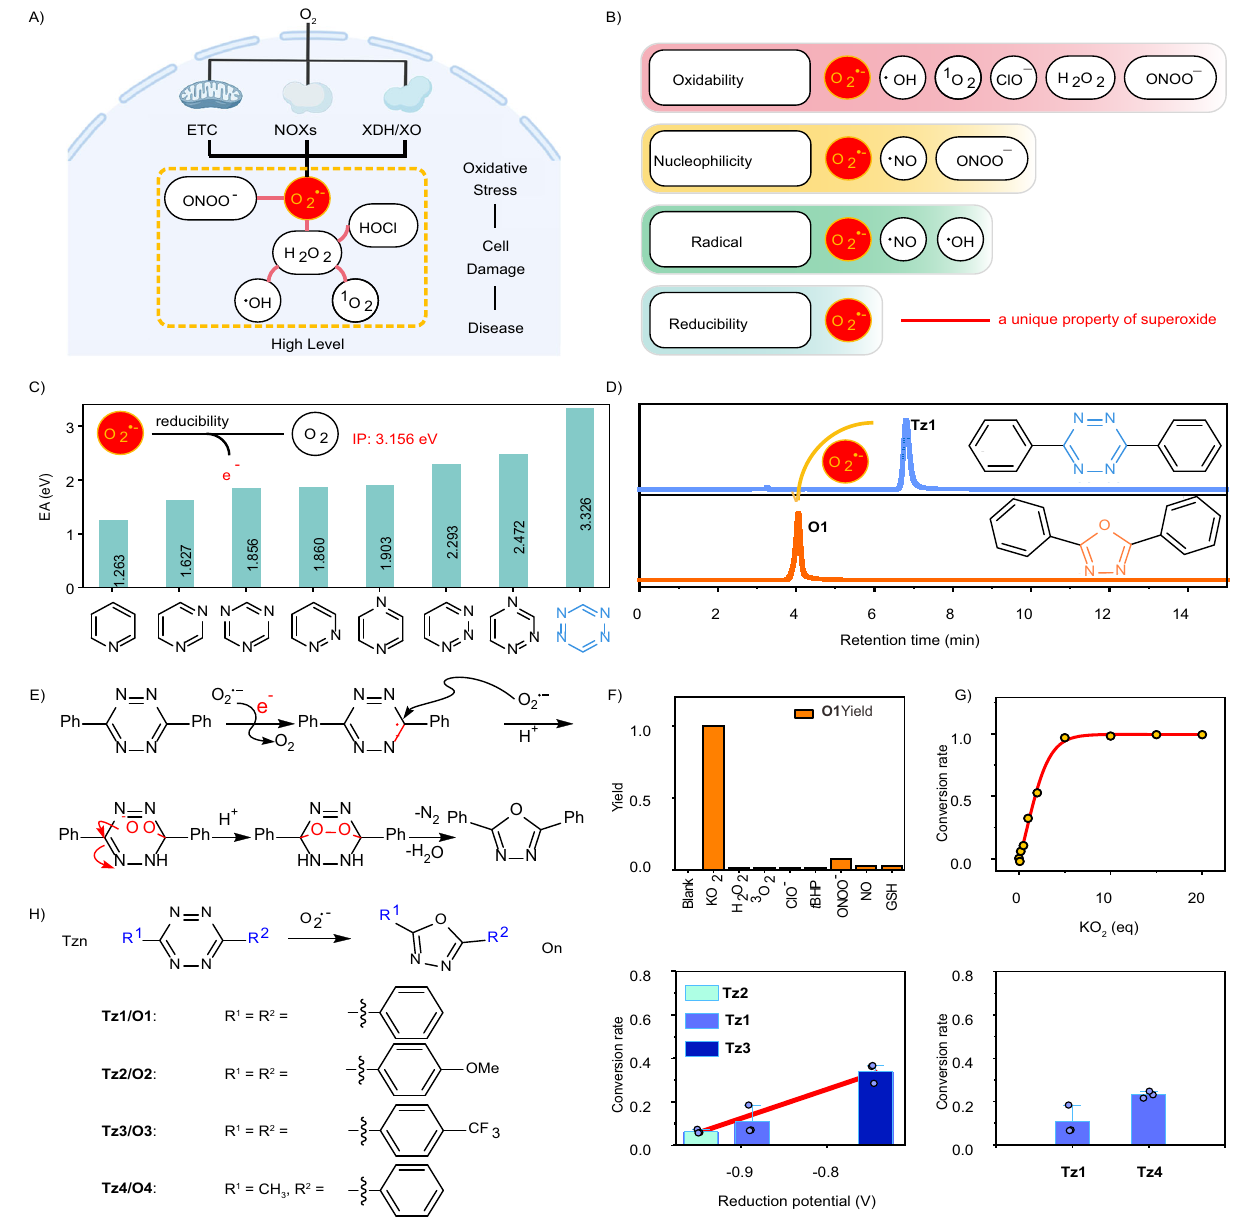
Fig.1|Designoftetrazine-basedprobesforsensingsuperoxide.A Superoxideas aprimaryROS in cells. This fi gurewascreated with BioRender.com. B Reactivity of various ROS. C Nitrogen substitution of benzene ring up-shifts its electron af fi nity (EA); the inset shows the ionization potential (IP) of the superoxide radical anion. D HPLC traces of Tz1 before and after the treatment of superoxide. E Proposed reactionmechanismbetween1,2,4,5-tetrazineandsuperoxidetoyield2,5-diphenyl-